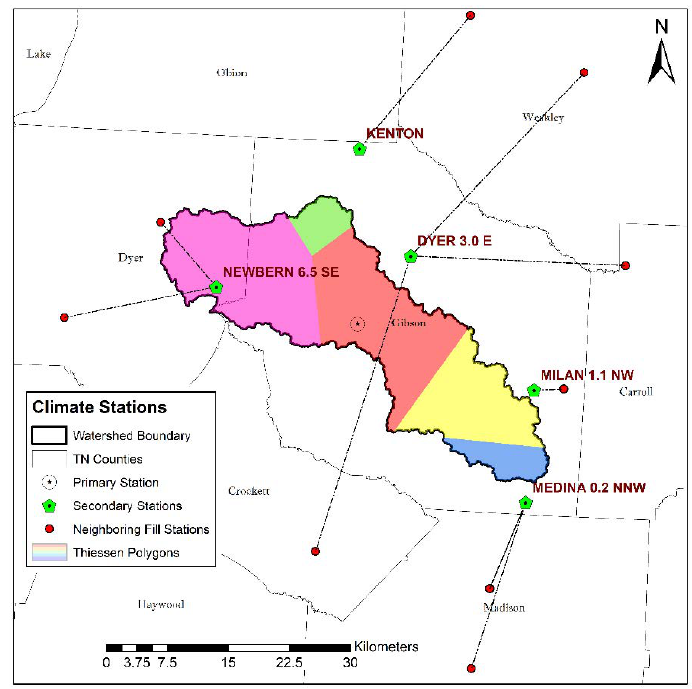
Figure 3. Climate station locations used in the